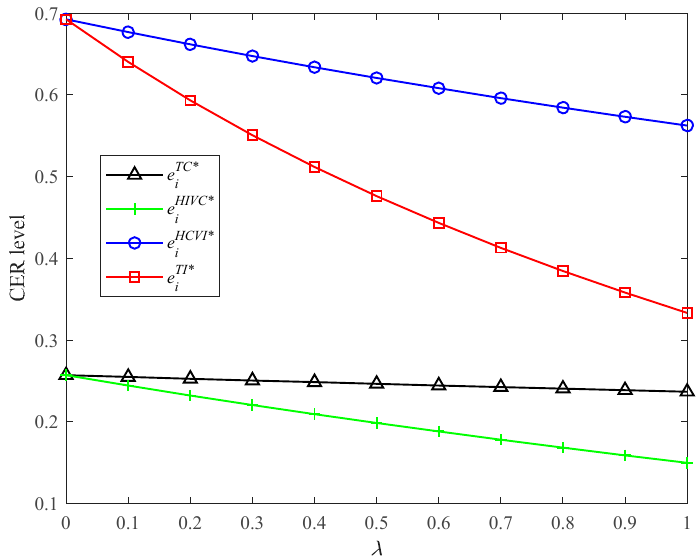
Figure 2. CER levels in four models with different 𝜆 .